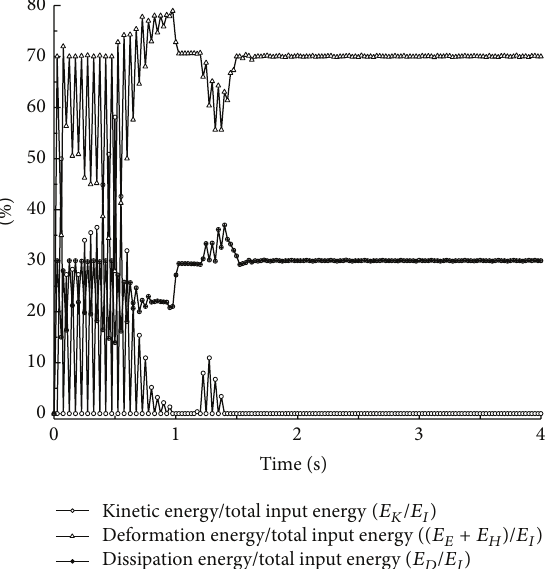
Figure 4: Time histories of percentages of structural energies to total input